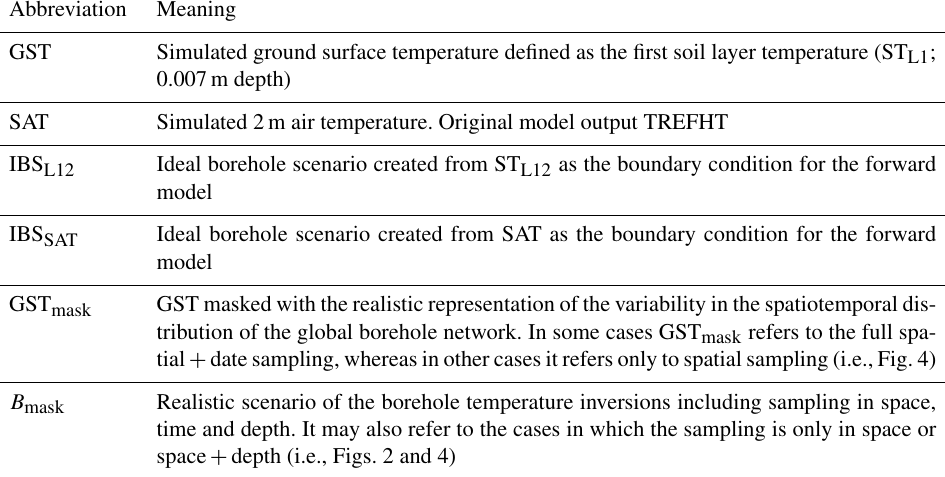
Table 4. Abbreviations used in this